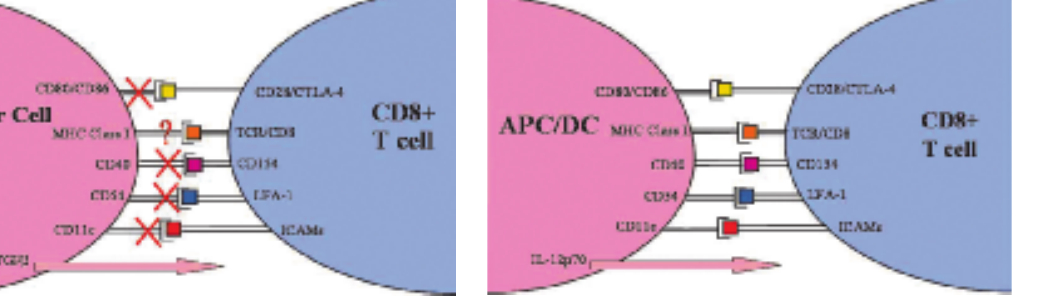
Tumour cells do not activate CD8 T cells. Tumour cells may or may not express MHC class I/peptide complexes on their surface, enabling recognition by previously activated T cells. They do not express the optimal arrangement of costimula- tory and adhesion molecules required for activation of naïve T cells. They may also secrete inhibitory cytokines such as IL-10 and TGF b . Abbreviations: ICAM, intercellular adhesion molecule; TCR, T cell receptor.